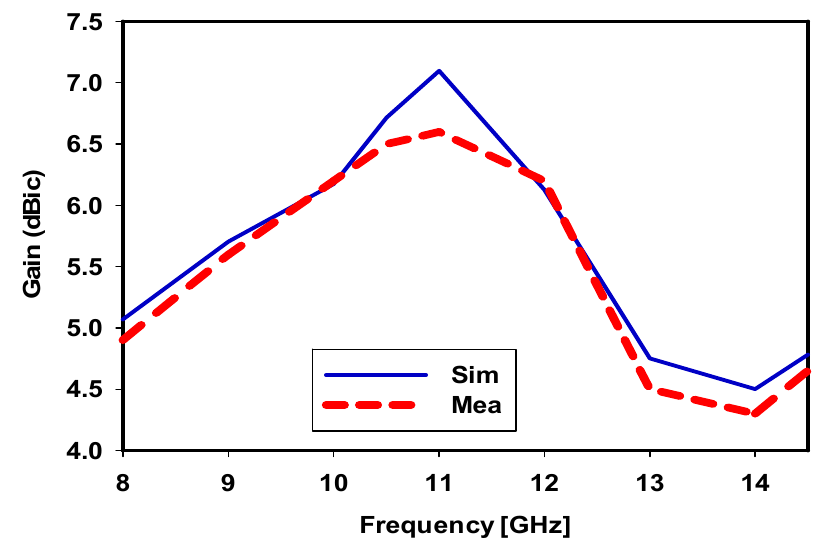
Figure 12. Simulated and measured realized gain of the design.